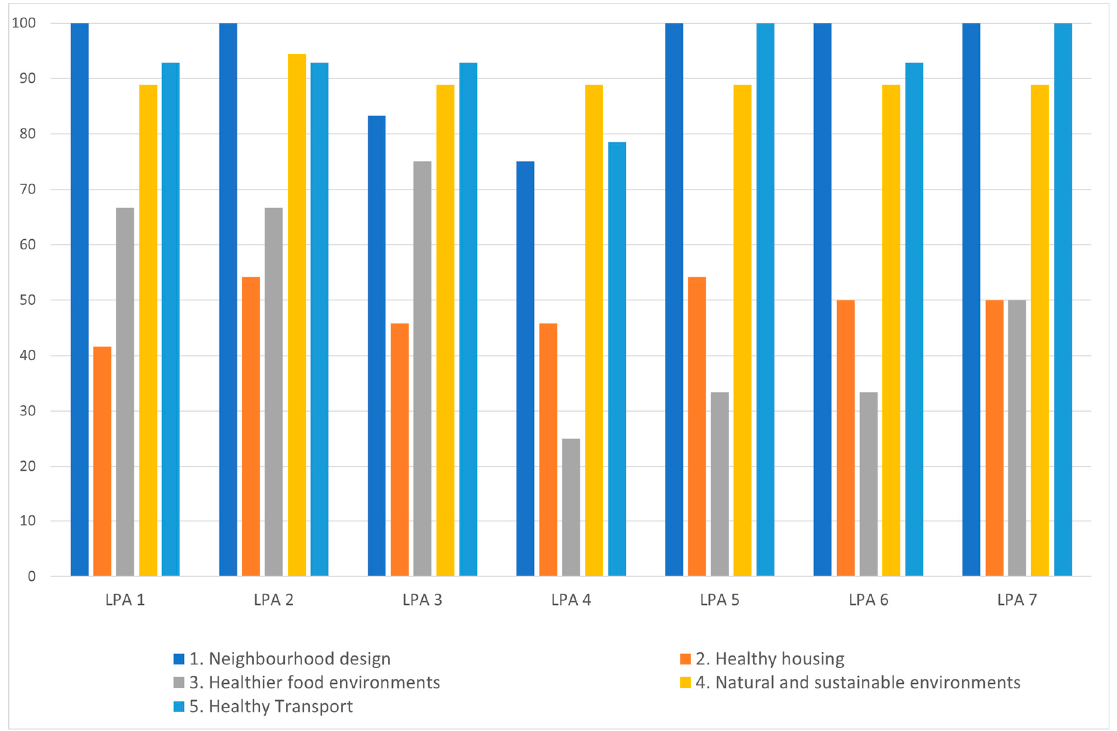
Figure 3. Determinants of Health percentage score for five themes, comparing seven local plans.